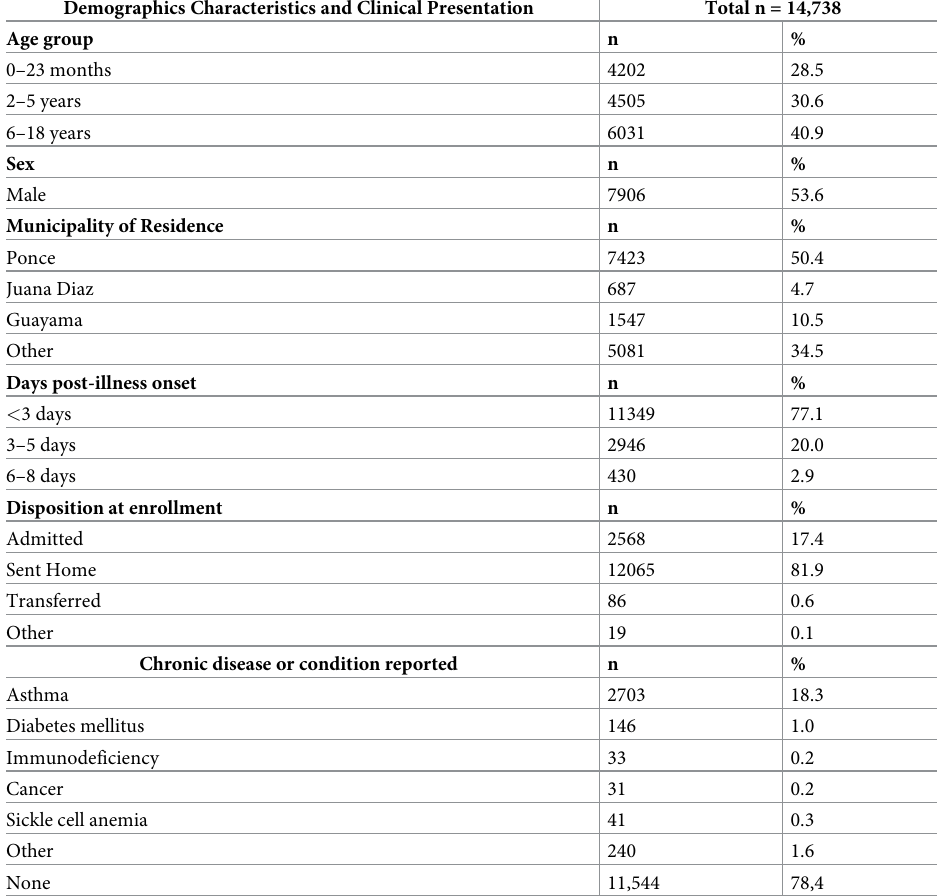
Table 1. Characteristics of pediatric patients, Sentinel Enhanced Dengue Surveillance System (SEDSS), Southern Puerto Rico, 2012–2018. Demographics Characteristics and Clinical